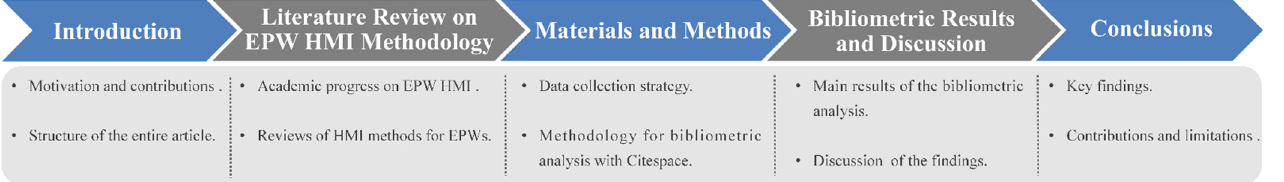
Figure 1. The structural outline of this article.